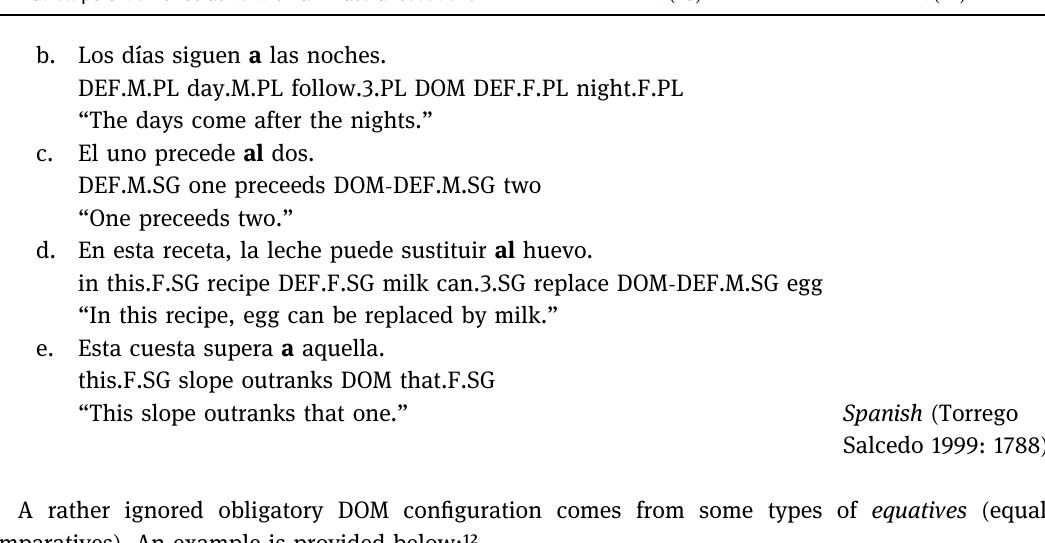
Animate inde fi nites with speci fi c readings only − Insensitivity to speci fi city ( Anim Neg Q ) +( 5 ) Clitic doubling of pronouns Clitic doubling of non - pronominal